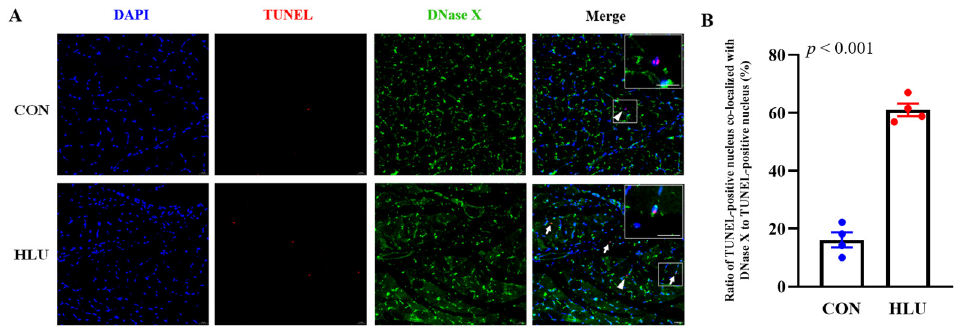
Figure 8. Ratio of TUNEL-positive nuclei co-localized with DNase X. ( A ) TUNEL assay and immunofluorescence staining on muscle slice in the CON and HLU groups. Nuclei were blue after DAPI staining. TUNEL-positive nuclei were red after TUNEL staining. DNase X was green after immunofluorescence staining. TUNEL-positive nuclei co-localized with DNase X were indicated by an arrow, TUNEL-positive nuclei not co-localized with DNase X were indicated by an arrowhead in Merge. Rectangular box view in upper right corner was magnified view of selected area in the picture. ( B ) Percentage of TUNEL-positive nuclei co-localized with DNase X to total TUNEL-positive nuclei. Each circle represented a value. n = 4. Data were analyzed by t -test. Data are shown as Mean ± SEM and considered statistically significant at p < 0.05. Scale bar, 20 µ